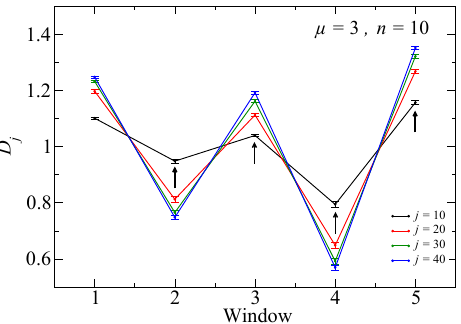
Figure 7. Box-counting fractal dimension for (cid:15) b (t) during quiet and active states for n = 10, with µ = 3. Active states correspond to states labeled “2” and “4”. (Taken from Domínguez et al., 2017.)